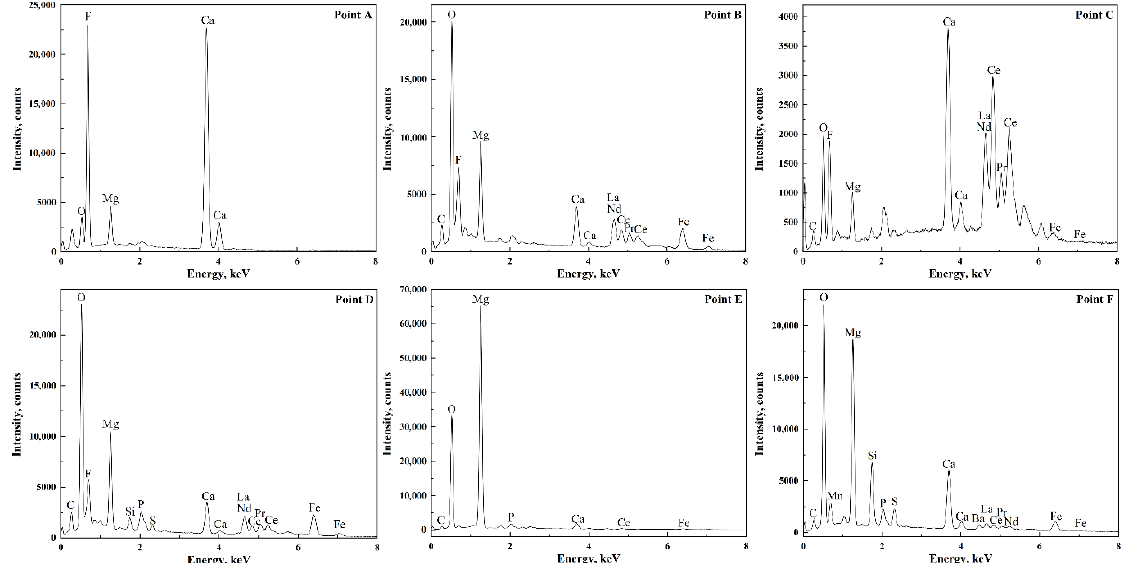
Figure 7. EDS analysis results of points in Figure 6.